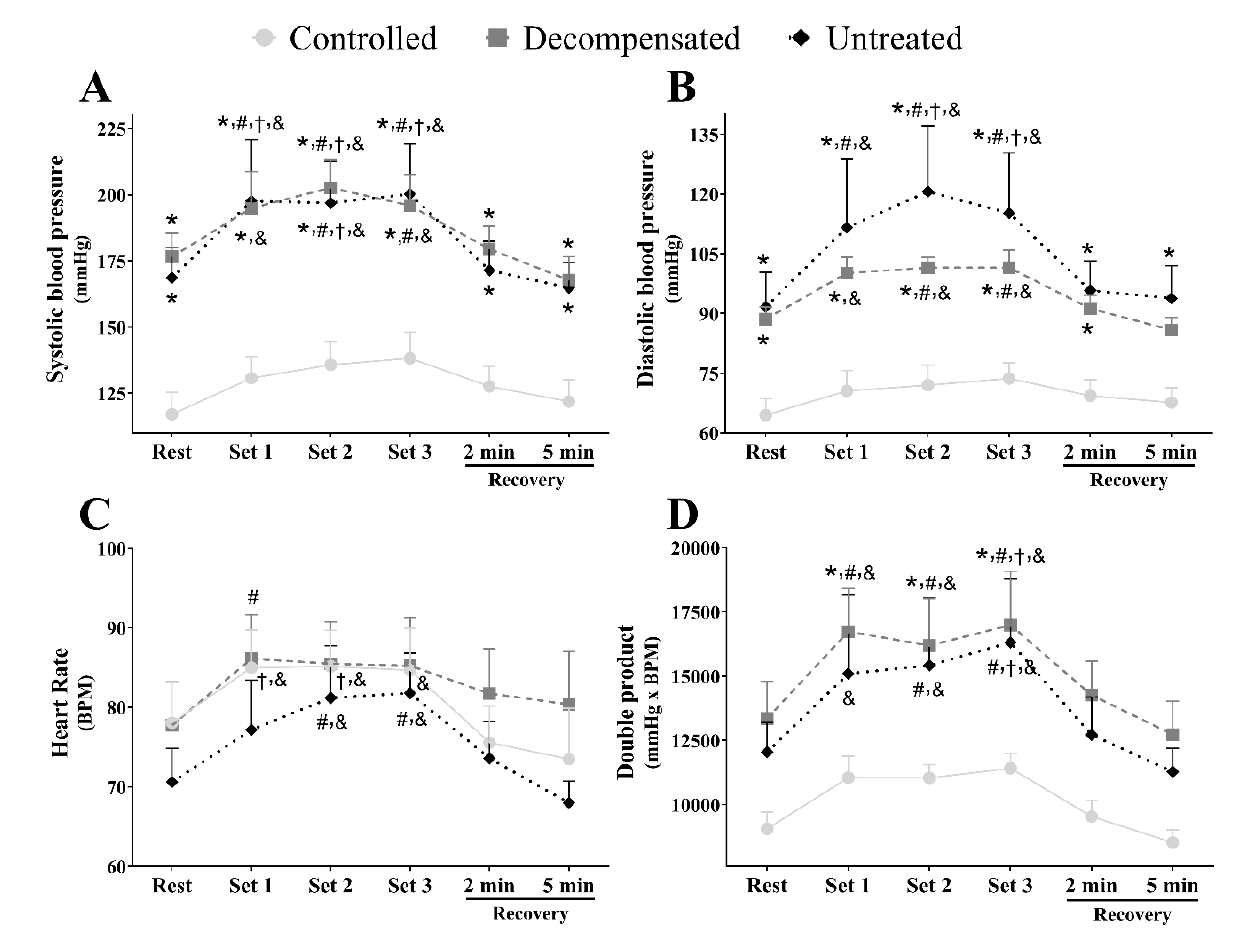
Figure 2 - Acute cardiovascular responses to a session of resistance exercise. *p<0.05 vs controlled; #p<0.05 vs rest, †p<0.05 vs 2 minutes, &p<0.05 vs 5 minutes in the same group. ANOVA two-way followed by Tukey